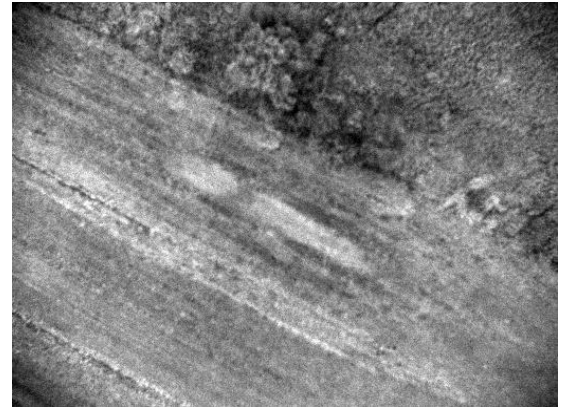
Figure 18 VIS camera view at 552nm.